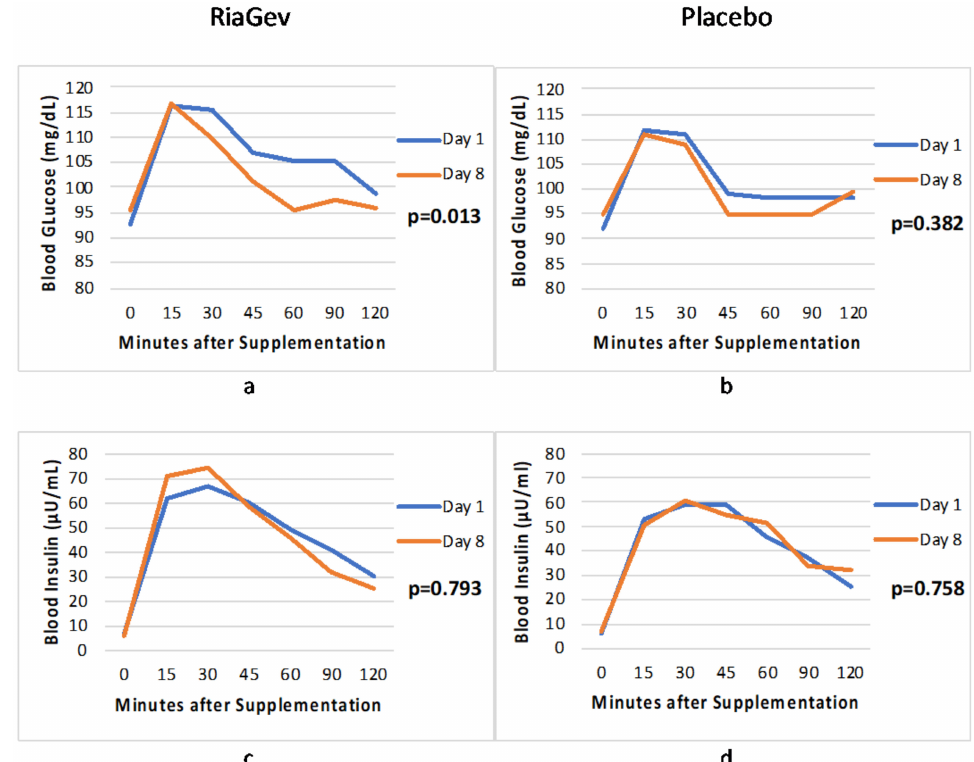
Figure 3. Oral Glucose Tolerance Test (OGTT) Profile Before (Day 1) and After Treatments (Day 8). ( a ) blood glucose in RiaGev group; ( b ) blood glucose in Placebo group; ( c ) blood insulin in RiaGev group; and ( d ) blood insulin in Placebo group. The p -value on each panel indicates its iAUC difference between Day 8 and Day 1. The blood glucose iAUC of the RiaGev group reduced significantly from Day 1 to Day 8 ( p = 0.013) while its overall insulin secretion did not change significantly ( p = 0.793). There is no significant change within the Placebo group for either blood glucose ( p = 0.382) or insulin ( p = 0.758).